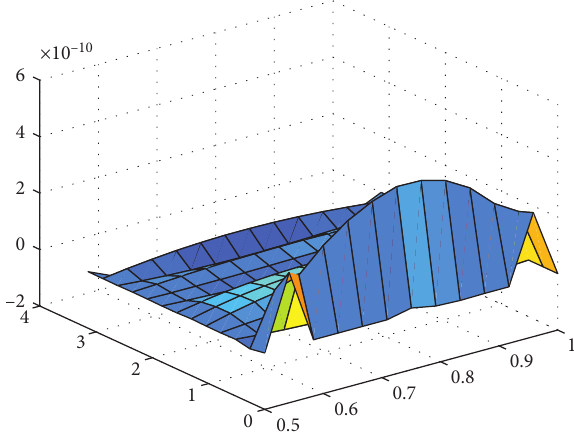
Figure 3: Errors of equidistant nodes with m � n � 12.